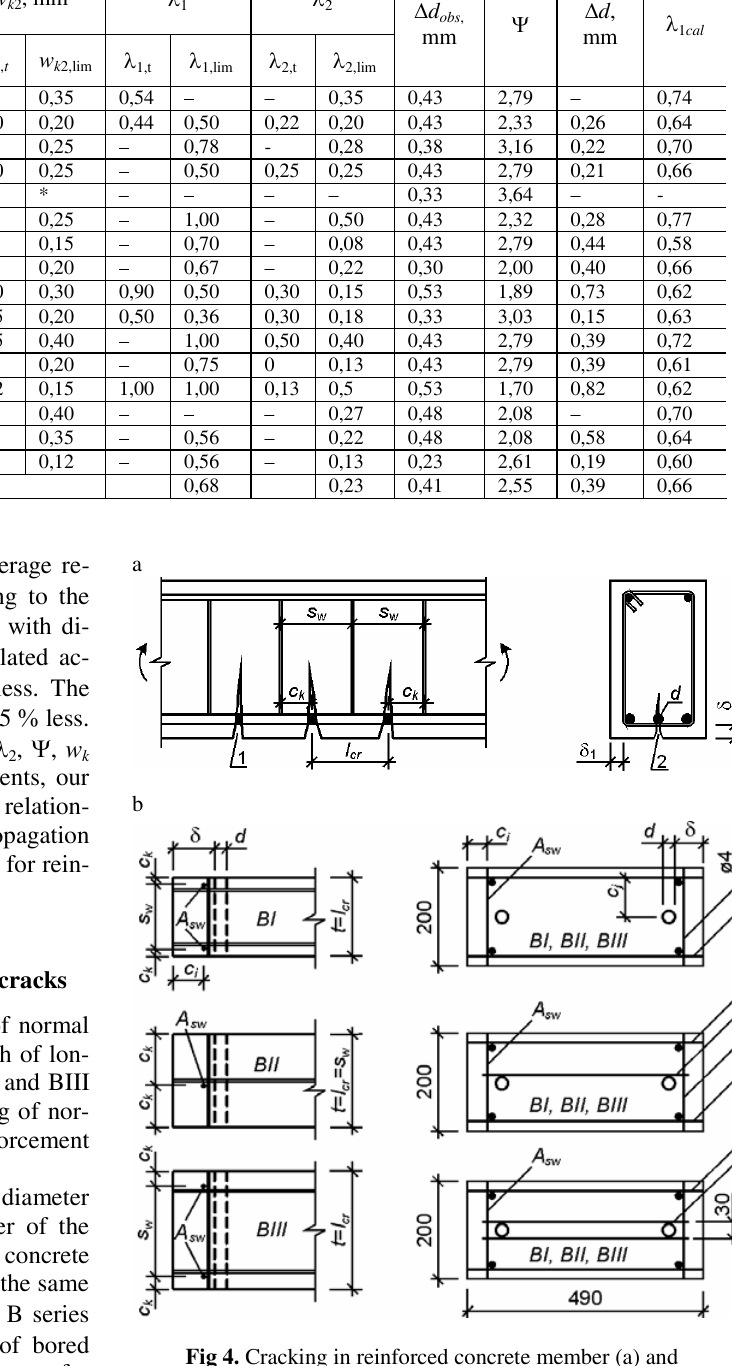
Table 1. Parameters of cracking in the concrete and reduction in bar diameter due to steel corrosion w k , mm w k 1 , mm w k 2 , mm λ